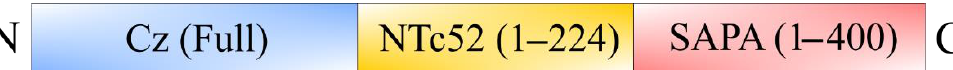
Figure 2. A chimeric antigen for vaccination against Chagas disease. A putative trivalent vaccine including the antigenic regions of full Cz, N-terminal Tc52 (NTc52 from 1–224) and SAPA from 1–400. The cDNA encoding that highly immunogenic fusion polypeptide can be synthesized and used either for a mRNA-based vaccine or a DNA-based vaccine against Chagas disease.